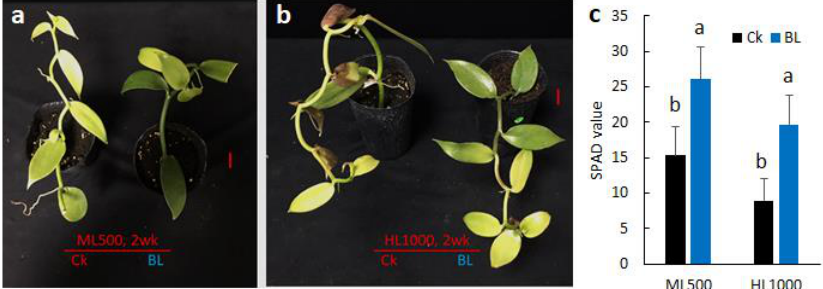
Figure 6. Blue-light-acclimation enhanced vanilla orchid growth after exposure to high irradiation. ( a ) Vanilla exposed to moderately high irradiation of 500 µ mole m − 2 s − 1 (ML500). ( b ) Vanilla exposed to high irradiation of 1000 µ mole m − 2 s − 1 (HL1000). BL, plant after BL-acclimation (BL-Ac) for 12 days. Red scale bars, 2 cm ( a , b ). Growth chamber temperature was at a constant 26 °C, 12 h photoperiod. ( c ) SPAD reading of vanilla orchid L3 after exposure to high irradiations of ML and HL for two weeks. Different letters indicate significant differences among treatments at p < 0.05, according to Duncan’s multiple range test (DMRT). Table 3. Comparison of vanilla orchids with or without BL-acclimation on Chl F parameters after exposure to ML500 and HL1000 conditions for two weeks.